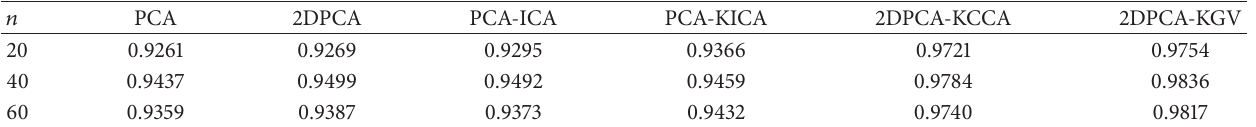
Table 4: The comparison of the average